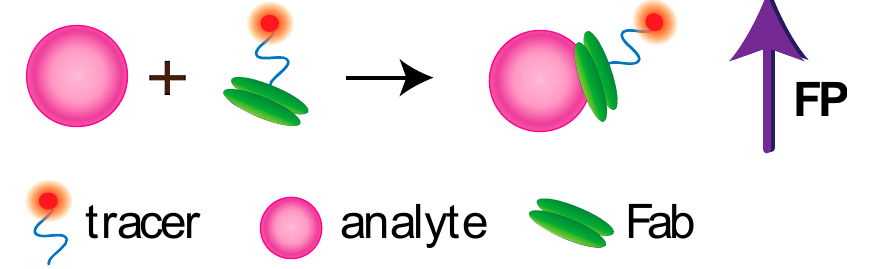
Figure 5. Noncompetitive FPIA using Fab fragment.